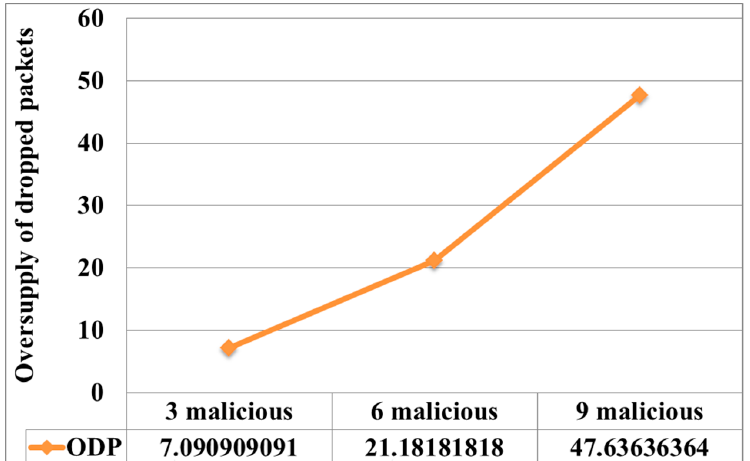
Figure 9. Change in the number of dropped packets for the network oversupply of dropped packets ( ODP i ) under the Black-Hole attack compared to normal network operation.